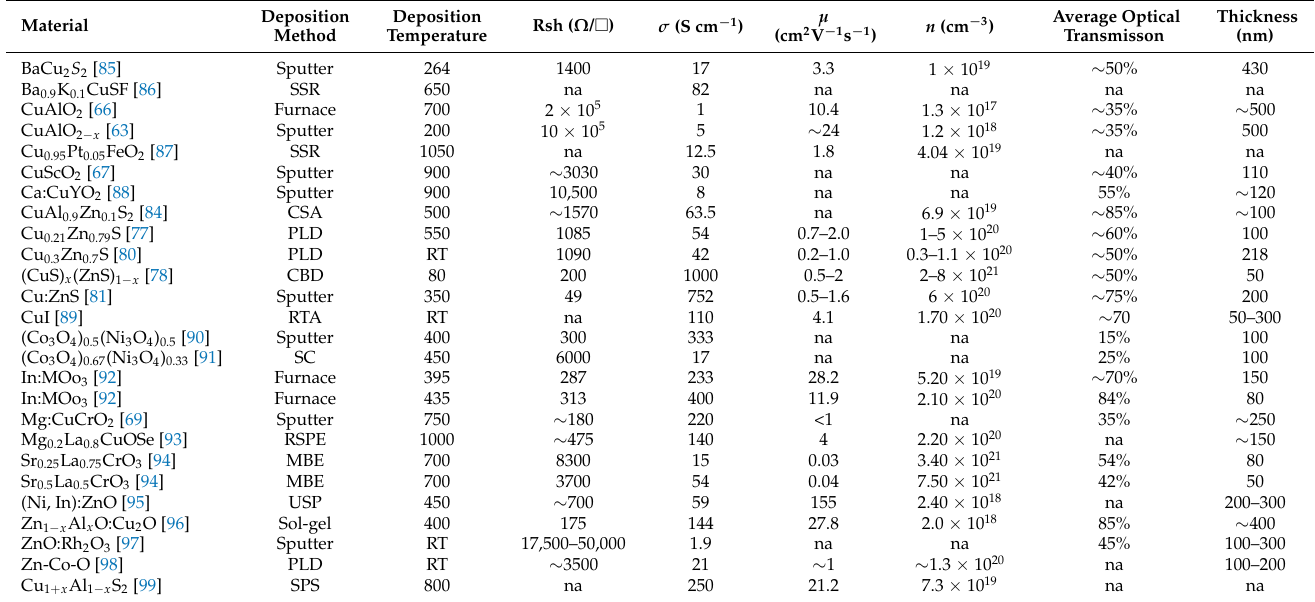
Table 2. List of most of the p -type transparent conductors.